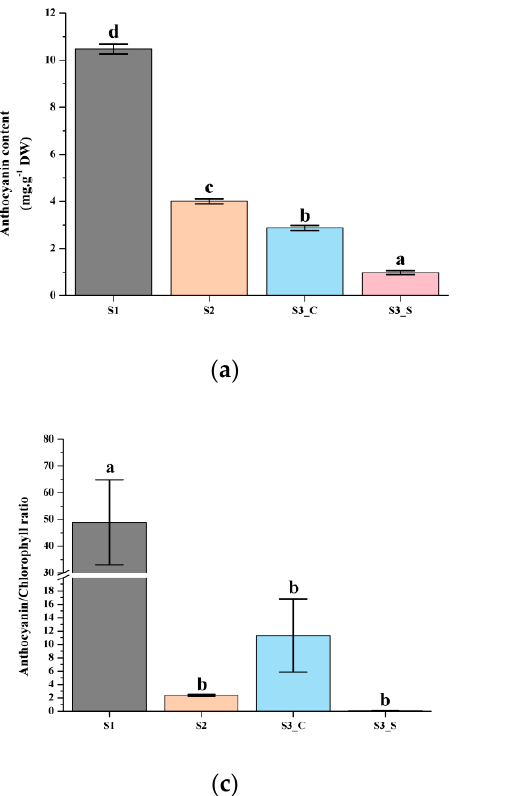
Figure 2. Pigment accumulation in ‘Y005-7’ leaves at different developmental stages. ( a ) Anthocyanin contents at S1–S3. ( b ) Chlorophyll contents at S1–S3. ( c ) Anthocyanin/chlorophyll ratio at S1–S3.